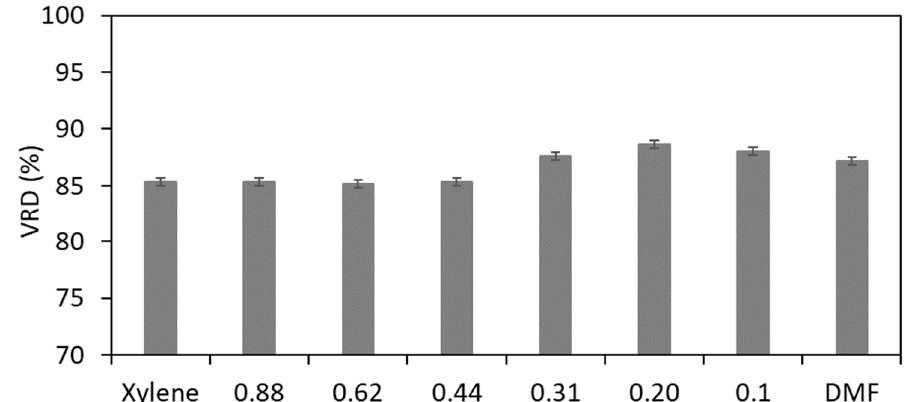
Figure 2. Effect of xylene/dimethylformamide (DMF) ratio in the viscosity reduction degree (VRD) of an extra-heavy oil at 30 ◦ C for a fixed diluent dosage of 5 vol % at a fixed shear rate of 10 s − 1 .